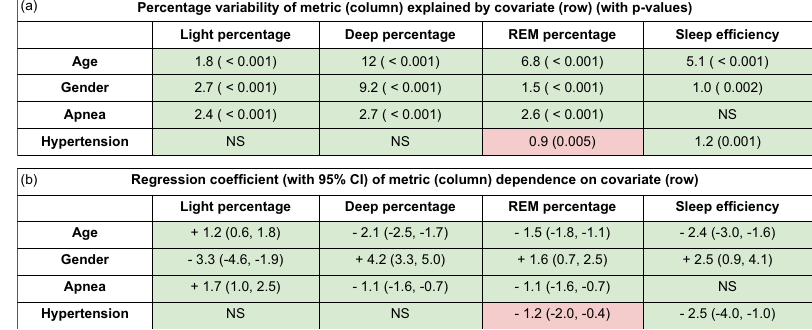
Fig. 6 Sleep covariate regression analysis. The tables below show results of regression analysis with the covariates on each row as independent variables and our algorithm predicted sleep metrics on each column as the dependent variable. The metrics are adjusted for age and gender before regressing on apnea, and adjusted for age, gender and apnea before regressing on hypertension. Boxes where the covariate was a signi fi cant predictor are fi lled with values, the rest are fi lled with “ NS ” . Boxes colored in green are those where our results qualitatively agree with a previous study 12 done using on PSG reference stages. Boxes colored in red are those where the previous study 12 and our results disagree. N = 800. a Regression coef fi cients with 95% con fi dence intervals. b Percentage of variance of sleep measure explained by covariate calculated as 100 * R-squared along with p